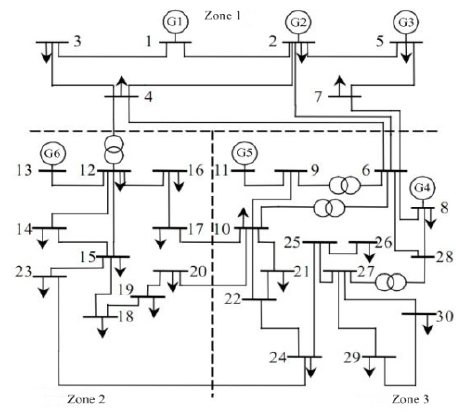
Figure 2. The IEEE 30-bus